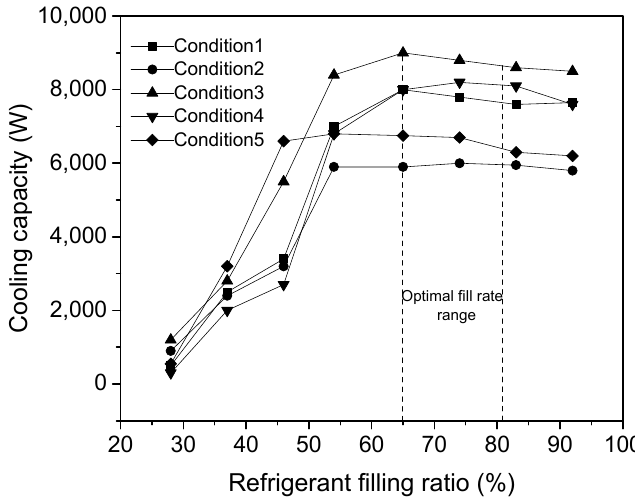
Figure 4. Relationship between cooling capacity and refrigerant filling rate under different temperature conditions.